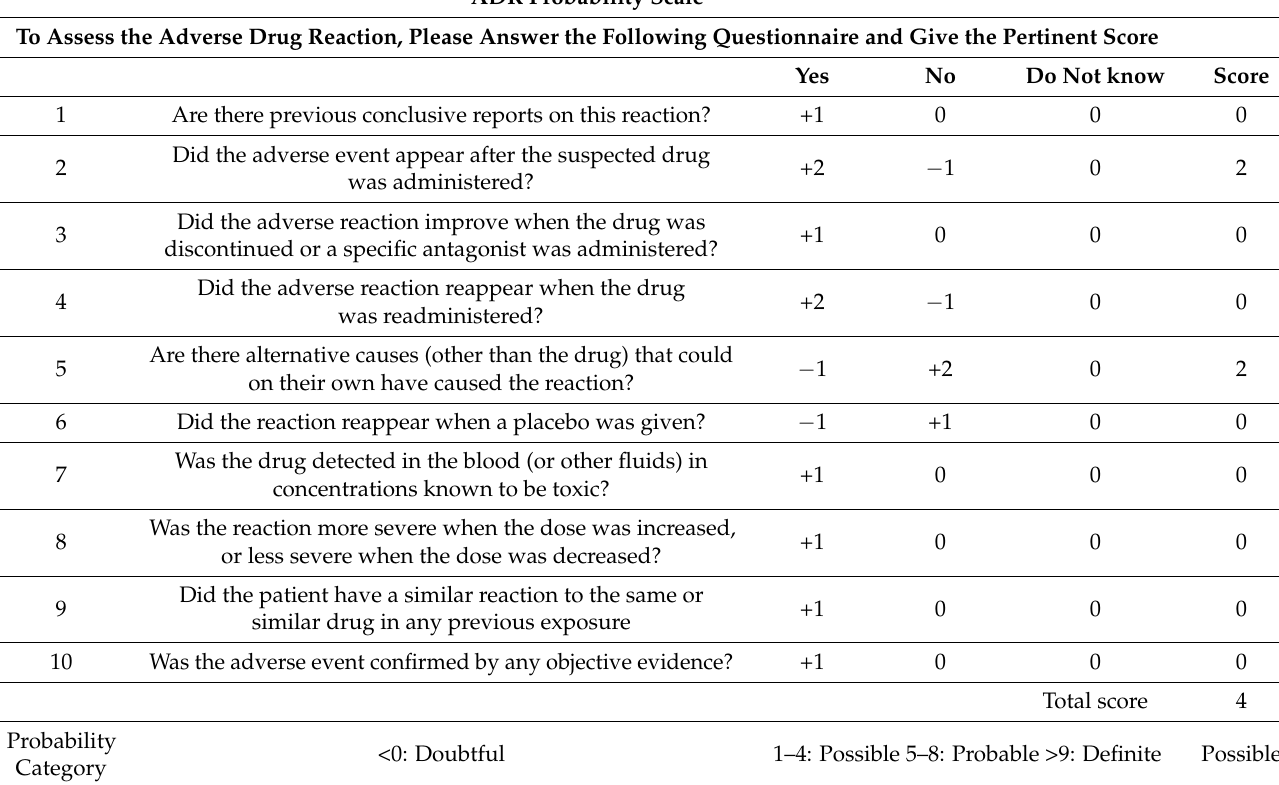
Figure 4. Ultra ‐ widefield Scanning Laser Ophthalmoscope ( SLO) retinal imaging on 13 October Figure 4. Ultra-widefield Scanning Laser Ophthalmoscope (SLO) retinal imaging on 13 October 2021: 2021: multifocal serous retinal detachment OU. multifocal serous retinal detachment OU.